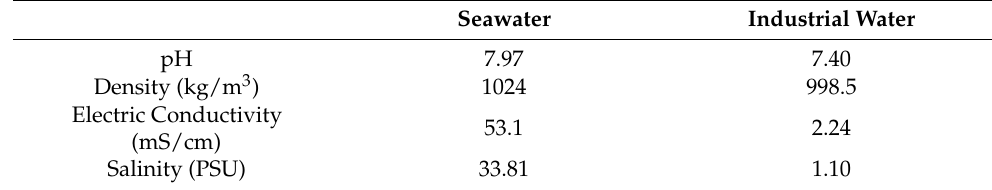
Table 2. Physical and chemical properties of seawater and industrial water at 23 ◦ C and 1